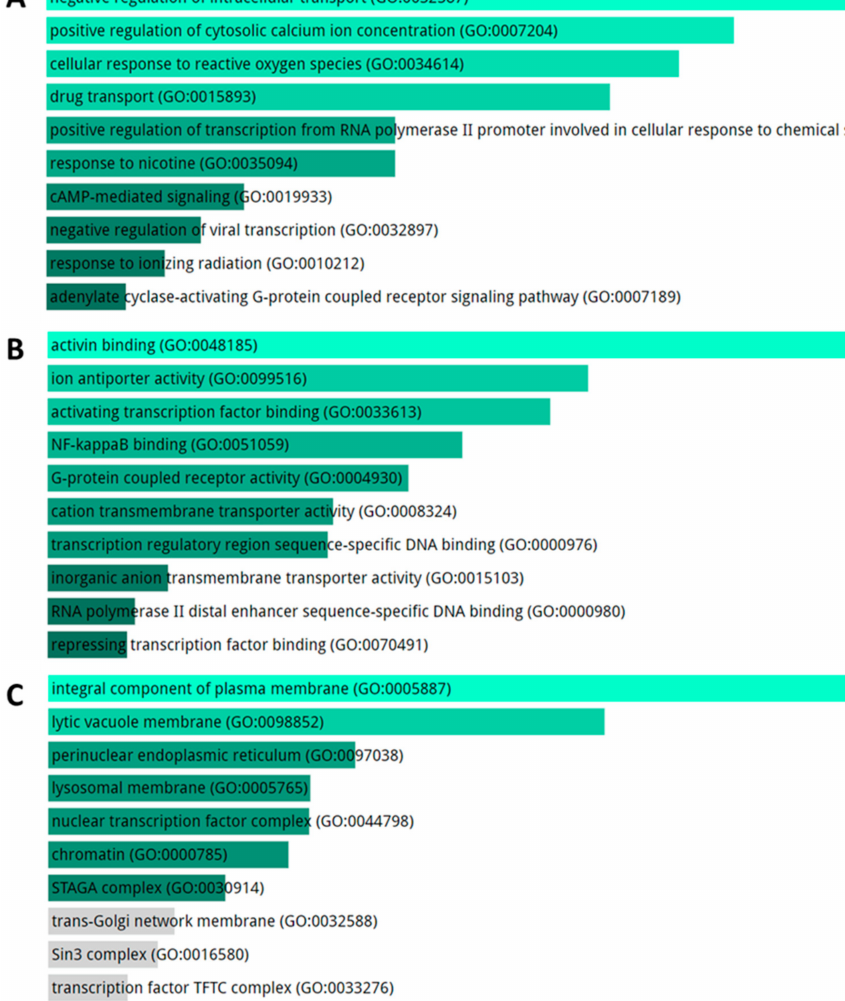
Figure 6. GO analysis for DE genes in SALS patients compared to healthy controls. TOP10 enriched GO terms for biological process ( A ), molecular function ( B ) and cellular component ( C ) The length of the bar represents the significance of that specific gene-set or term. The brighter the color, the more significant that term is, and the grey color refers to non-significant